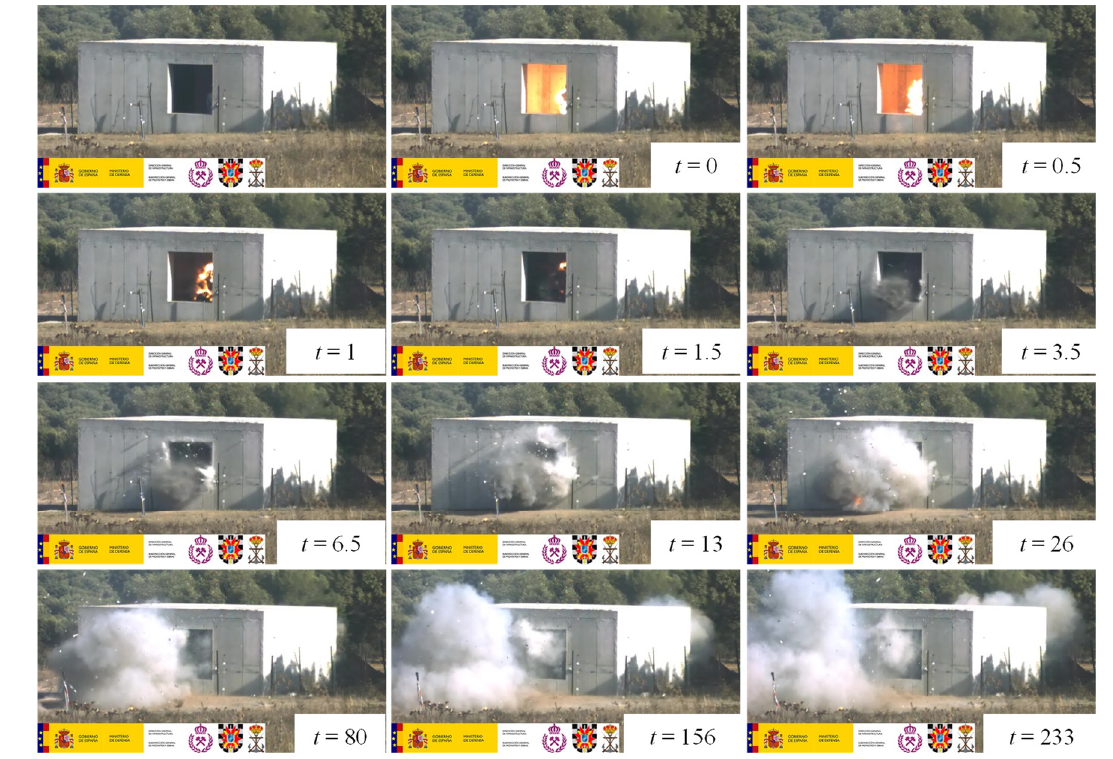
Figure 5. Sequence of images obtained with HSC in trial T4: ANFO. Time in milliseconds; the reference time is the first frame of the video where the detonation is observed.